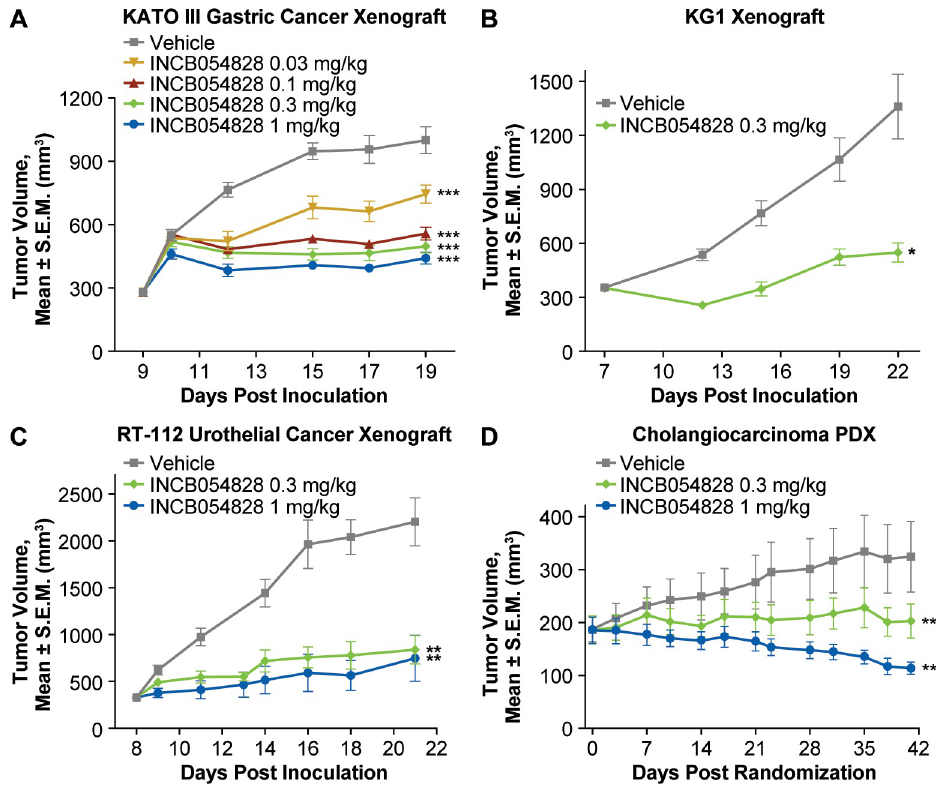
Fig 4. Efficacy of INCB054828 in tumor models with FGFR alterations. (A) KATO III (FGFR2-amplified) gastric cancer model. Severe combined immunodeficiency mice bearing KATO III tumors were administered INCB054828 (0.03, 0.1, 0.3, or 1 mg/kg) or vehicle by gavage once daily for 10 days. The mean tumor size is plotted for each group of 8 mice. ��� P < 0.001 vs vehicle. (B) KG1 ( FGFROP2-FGFR1 fusion positive) AML model. Humanized NSG mice bearing KG1 tumors were administered INCB054828 (0.3 mg/kg) or vehicle by gavage once daily for 14 days. The mean tumor size is plotted for each group of 6 mice. � P < 0.05 vs vehicle by paired t -test. (C) RT-112 ( FGFR3-TACC3 fusion positive) bladder carcinoma model. RNU immunocompromised rats bearing RT-112 tumors were administered INCB054828 (0.3 or 1 mg/kg) or vehicle by gavage once daily for 14 days. The mean tumor size is plotted for each group of 7 mice. �� P < 0.01 vs vehicle. (D) CTG-0997 ( FGFR2-TRA2B fusion positive) cholangiocarcinoma PDX model. Tumor bearing nu/nu mice were administered INCB054828 (0.3 or 1 mg/kg) or vehicle by gavage once daily for 42 days. The mean tumor size is plotted for each group of 12 mice. �� P < 0.01 vs vehicle. S.E.M., standard error of the mean.